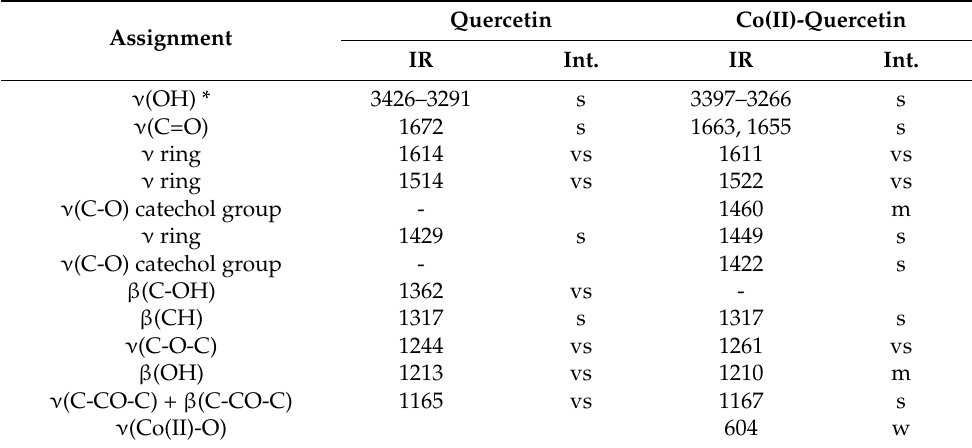
Table 1. The wavenumbers and intensity of selected bands from the FT-IR and FT-Raman spectra of studied compounds. Quercetin Co(II)-Quercetin Assignment IR Int. IR